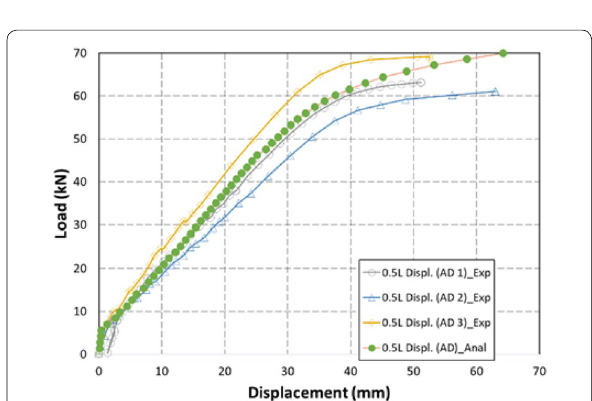
Fig. 20 AD comparison with FEM